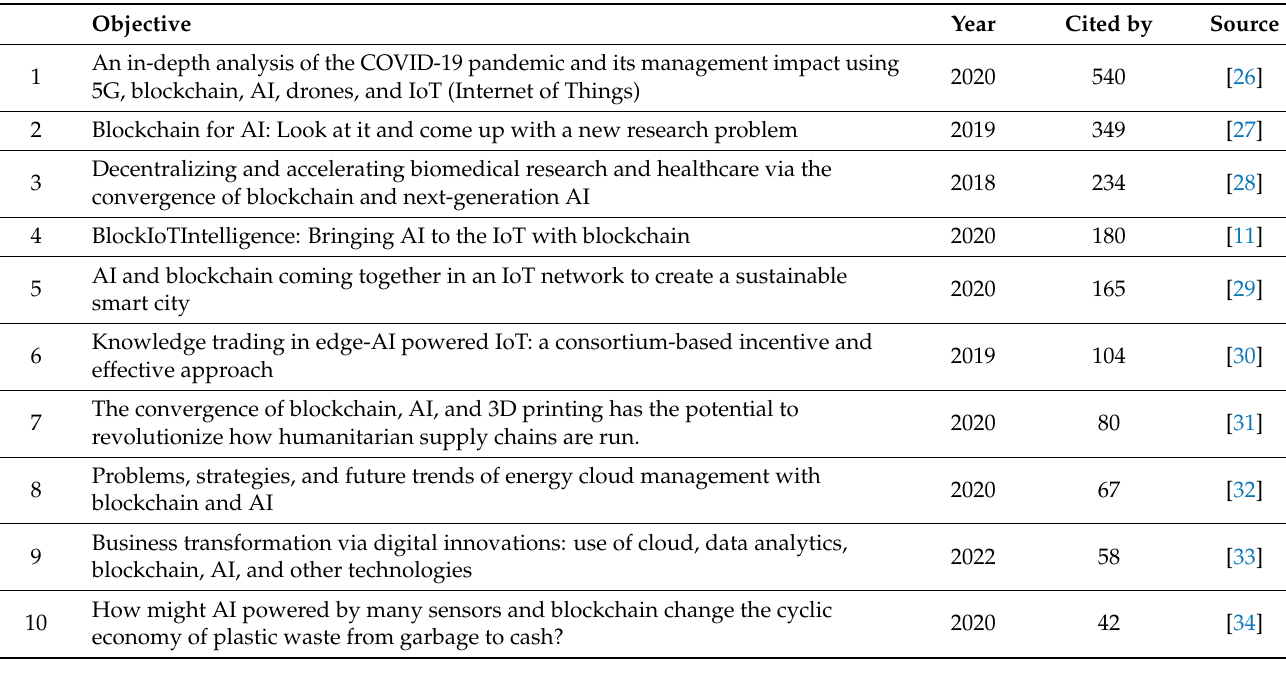
Table 1. Top 10 publications between 2012 and 2022 in terms of citations. The high citation rate indicates that the combination of AI and blockchains is significant and progressing.